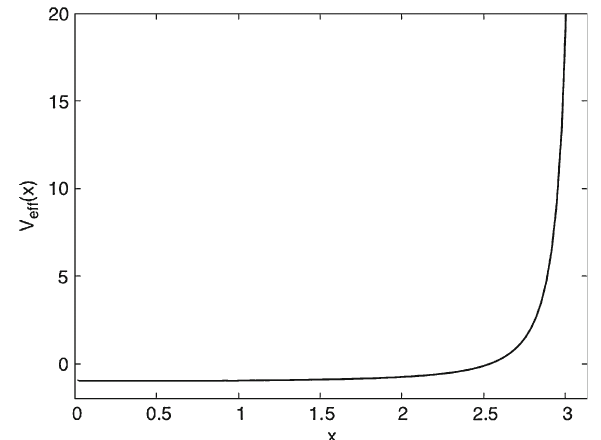
Fig. 1 Graphical representation of the effective potential for d = 4 and M = 1 (sphere of unit